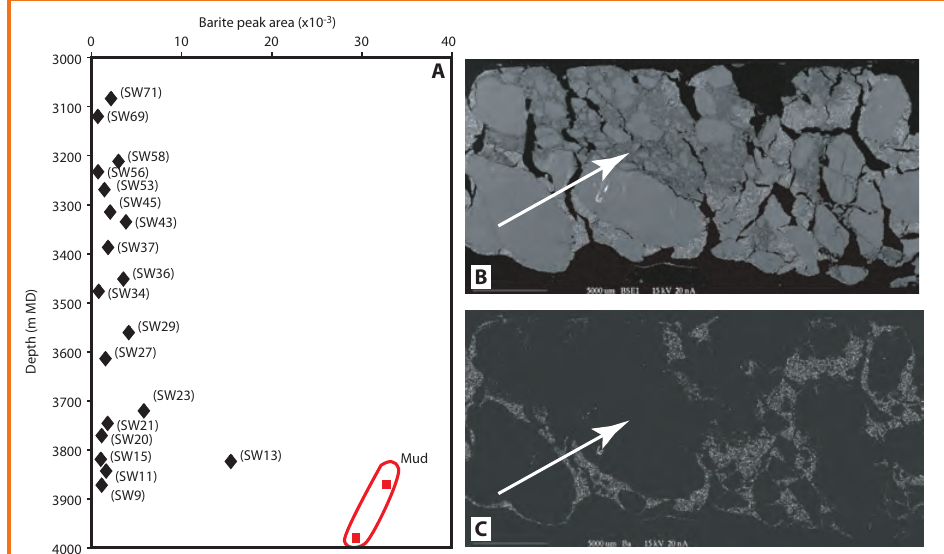
Figure 2. [A]. Relative barite concentrations in side wall cores from XRD patterns. Drilling mud samples are shown in red. [B] BSE image of SW61 (10461’ MD). [C] Barium scans of SW61. The breccia with the bright (barite-rich) matrix is drilling- related, while the breccia indicated by the white arrow is